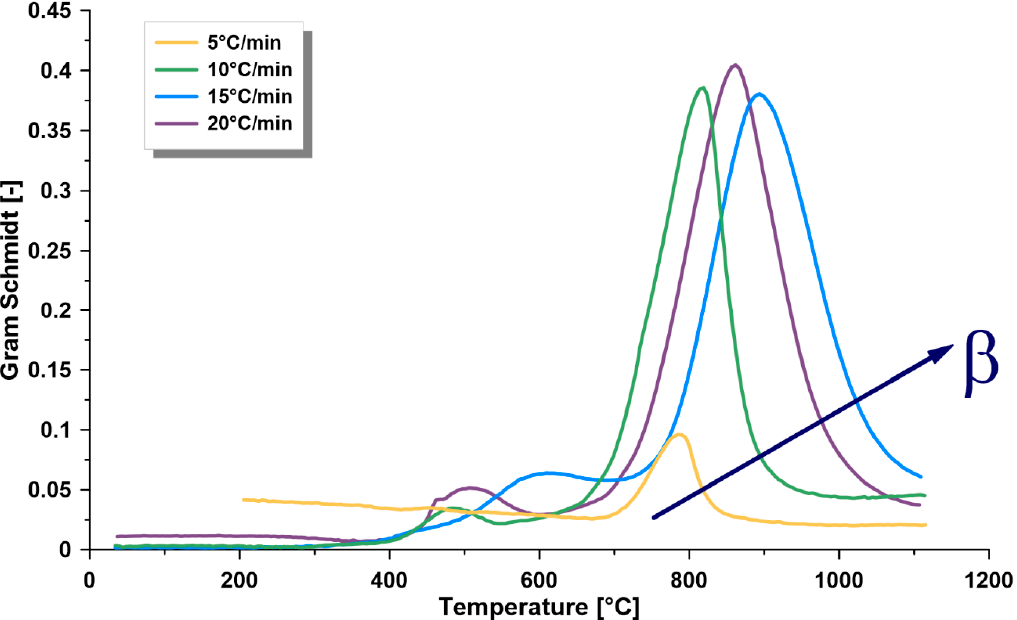
Figure 4. Gram–Schmidt (GS) signals of the heated oil shale samples at four heating rates ( β ) of 5, 10, 15, and 20 °C/min and a nitrogen environment showing the gas evolving region in the temperature range of 25–1100 °C, determined as the peak temperatures.